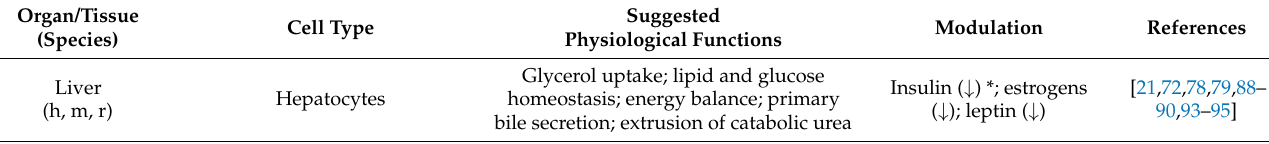
Table 1. Sites of expression, physiological roles and modulation of human and rodent